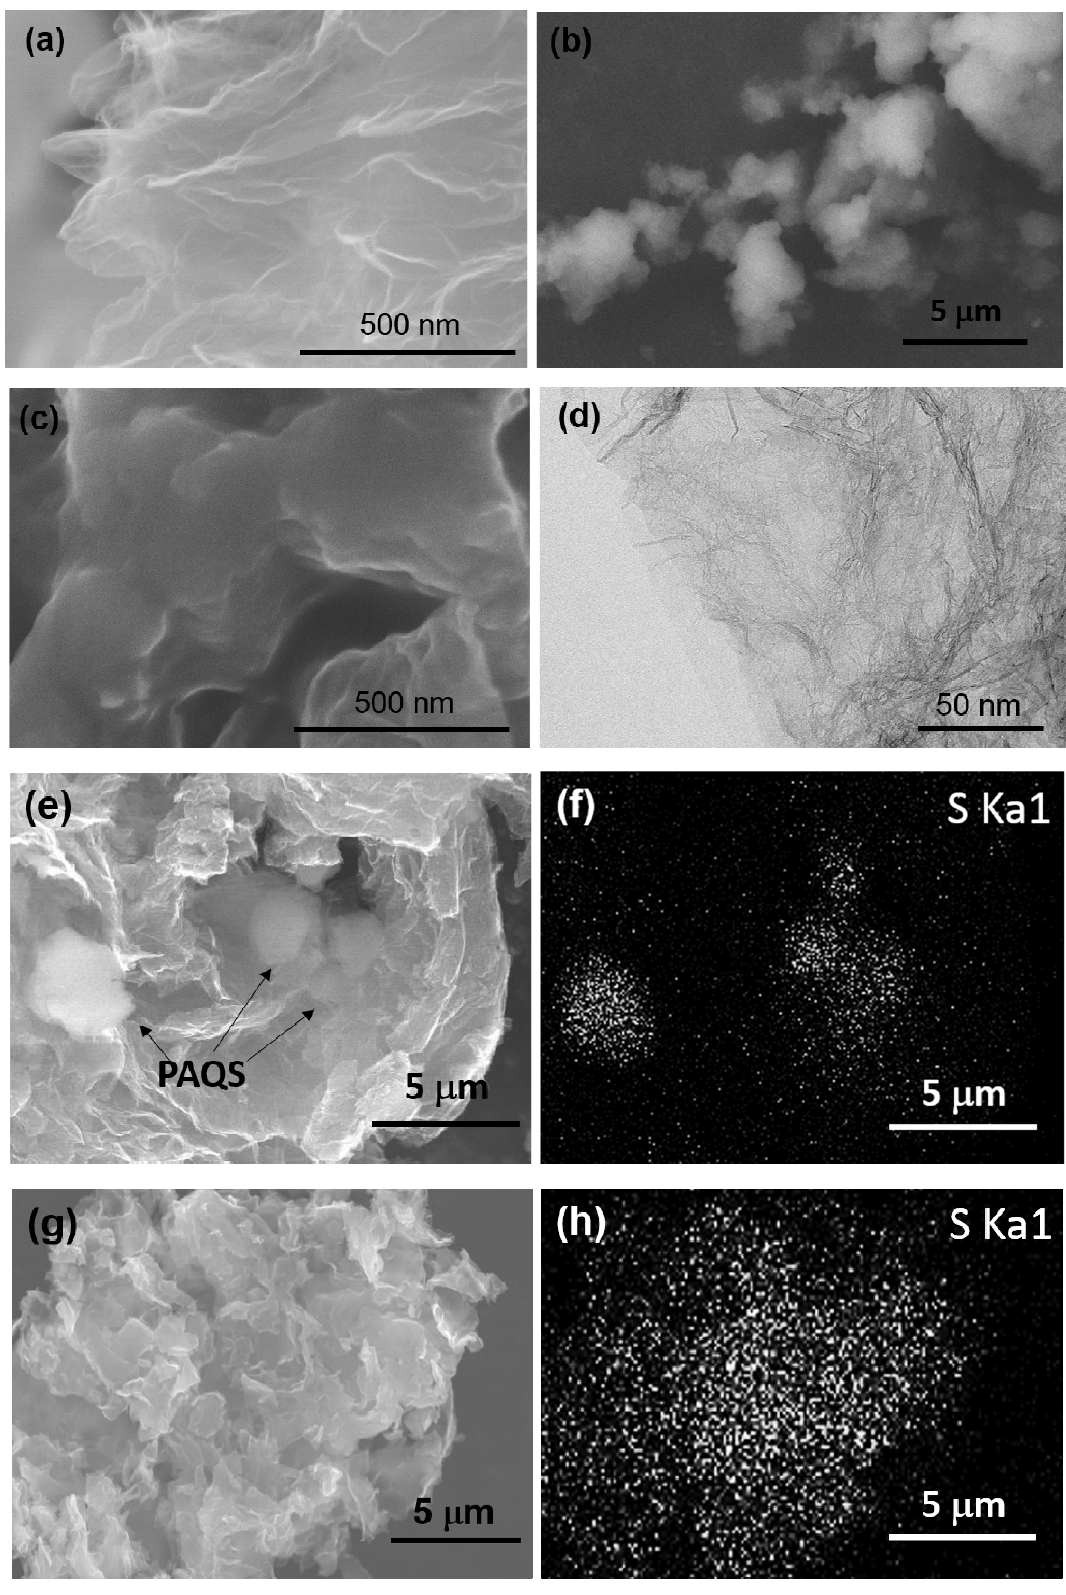
Figure 5. SEM images of ( a ) GSs; ( b ) PAQS; and ( c ) PAQS/GSs; ( d ) TEM image of PAQS/GSs. SEM images and energy-dispersive X-ray (EDX) sulfur elemental mapping images of ( e , f ) PAQS/GS(m) and ( g , h )